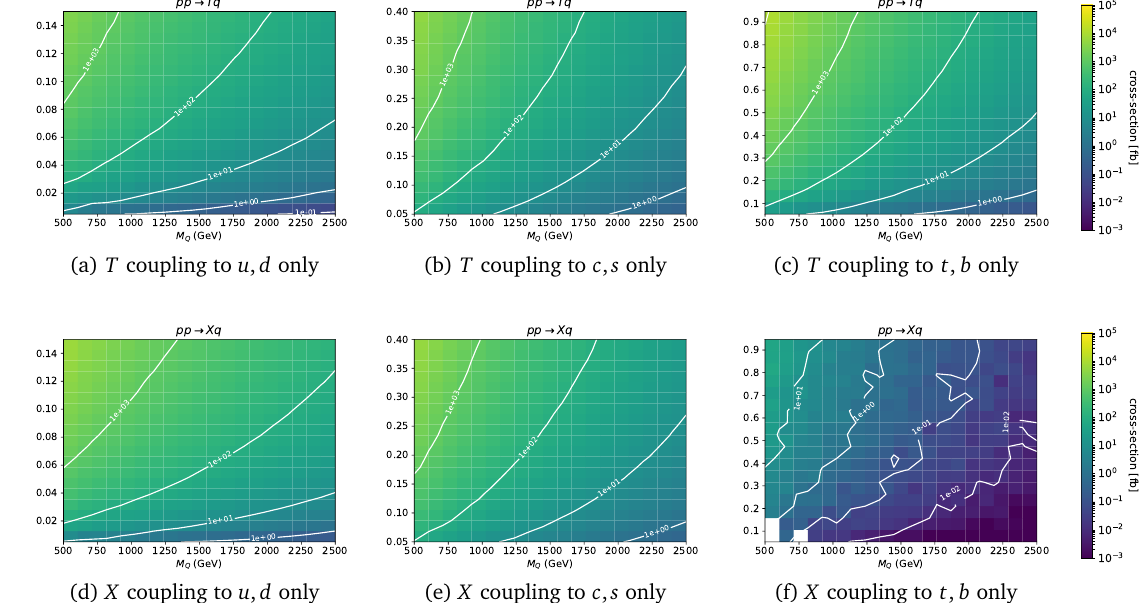
Figure 4: Leading-order cross-sections extracted from Herwig for production of a T and X with a SM quark as a function of M and κ , for 13 TeV pp collisions, in the Q W : Z : H = 1 scenario, assuming couplings to individual generations of quarks. : 1 : 1 2 4 4 The white lines indicate the contours for production cross-sections in multiples of 10. First-generation couplings lead to higher production cross-sections, as a result of valence-quark-induced diagrams, while second and third-generation couplings lead to suppressed production rates, according to the relevant quark PDFs. X + q production goes from being the dominant production process at the LHC if X couples to first-generation quarks only, to vanishing if X couples to third-generation quarks only. White cells indicate corners of phase-space where the process in question is highly subdominant, and therefore where the cross-section was not sampled during the Herwig